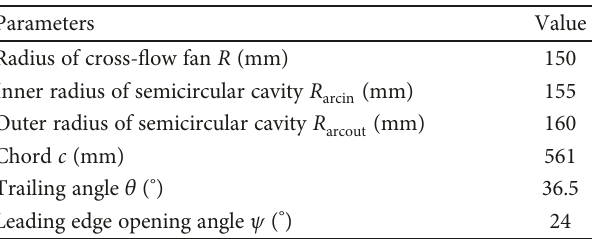
Figure 5: Fan-wing section dimension Table 1: Geometry of Fan-wing airfoil parameters.